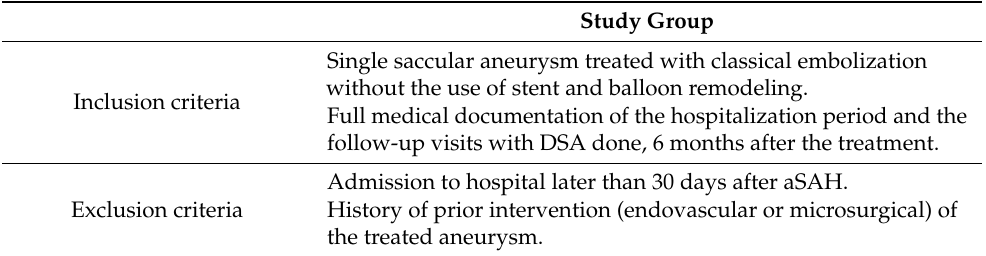
Table 1. Inclusion and exclusion